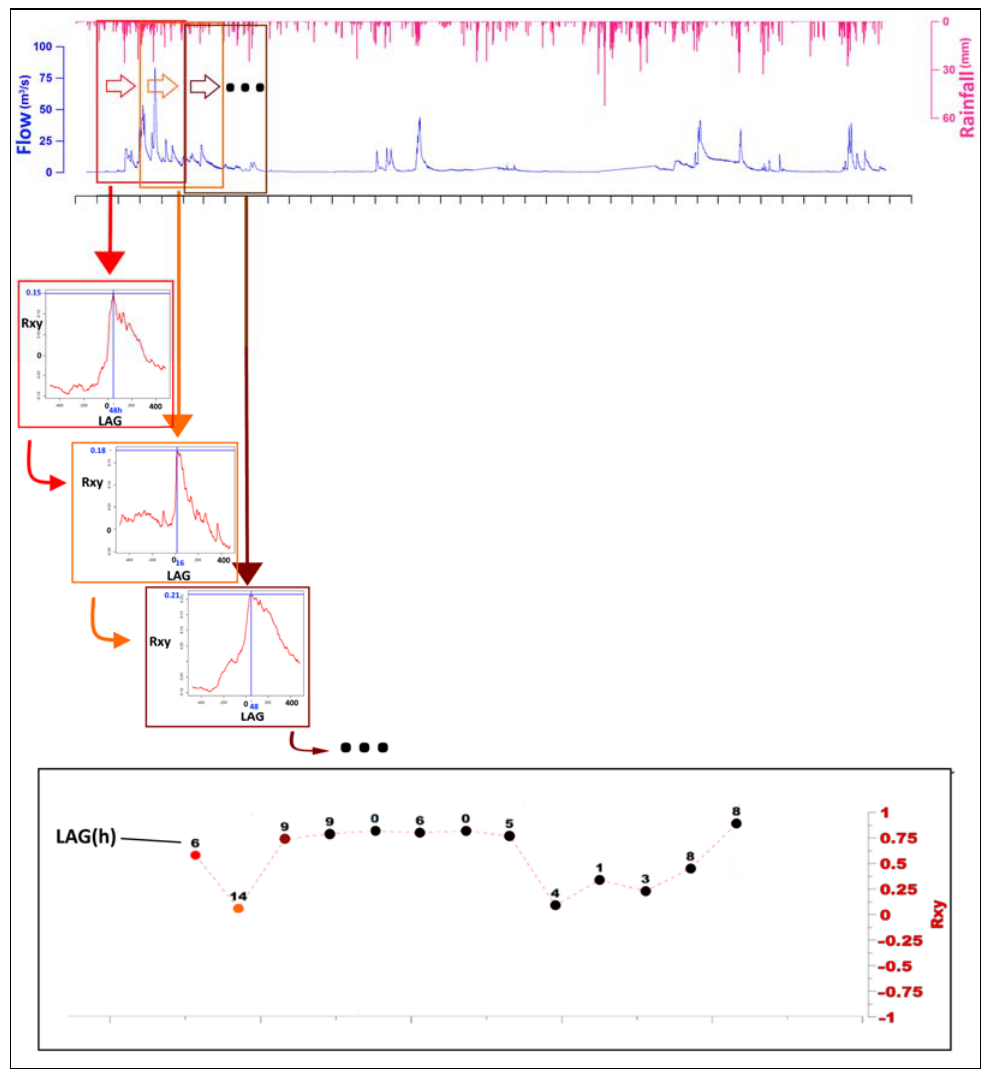
Figure 2. Illustration of a sliding window CCA between rainfall and outlet flow, adapted from Del- bart.